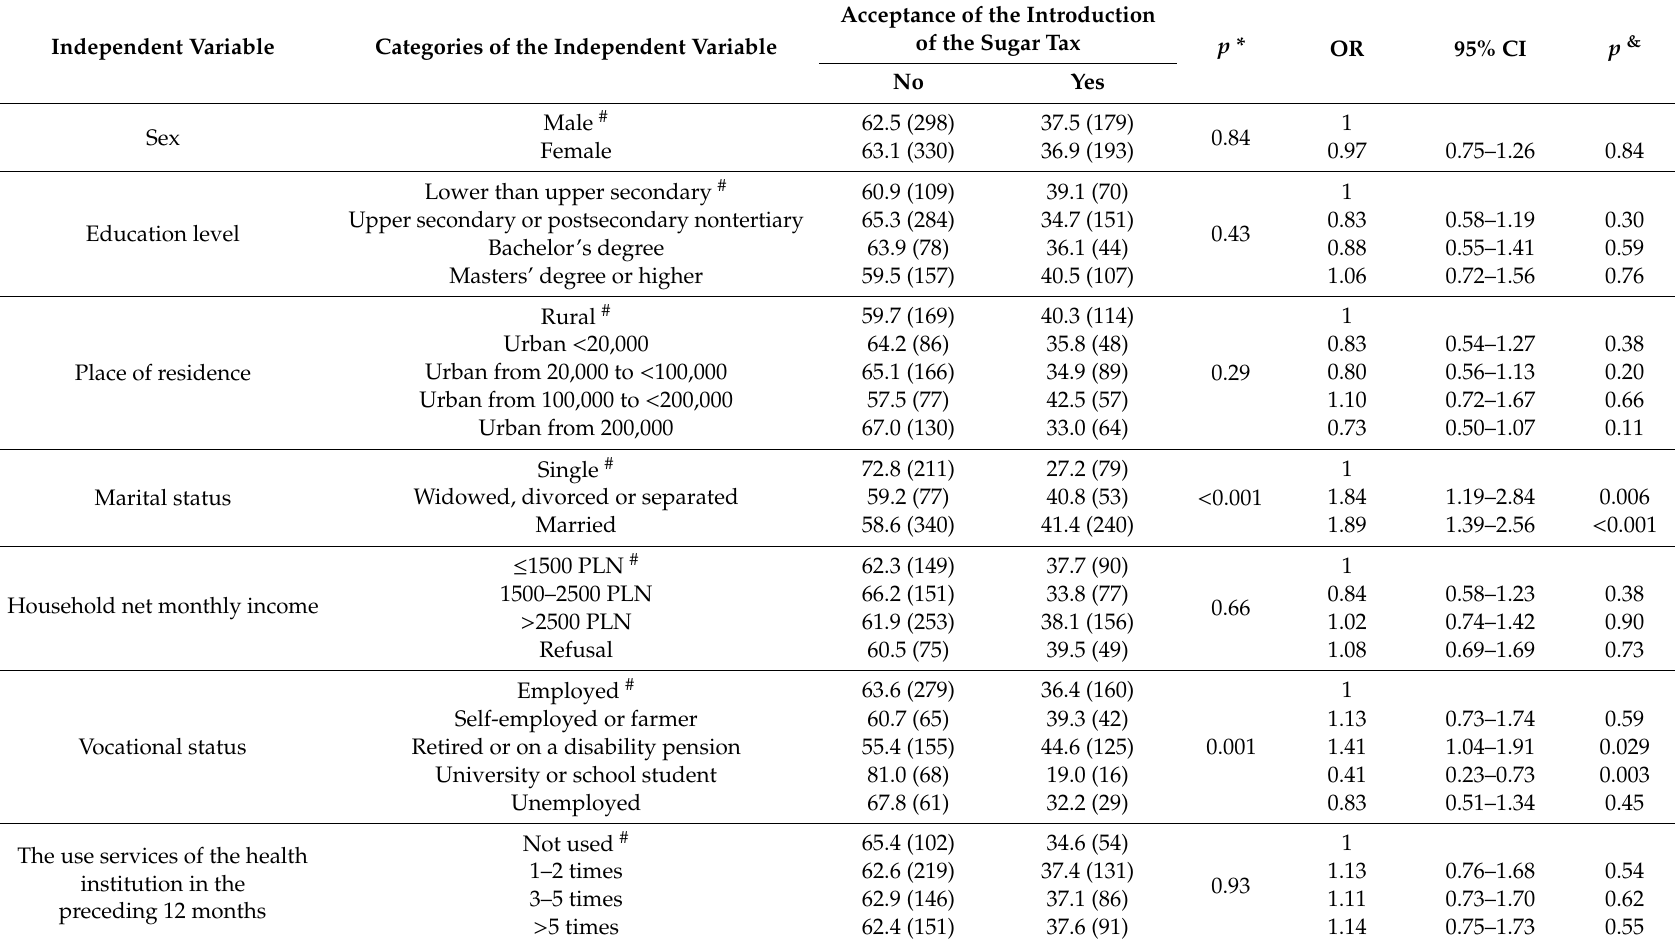
Table 3. The determinant of the opinion about the introduction of the sugar